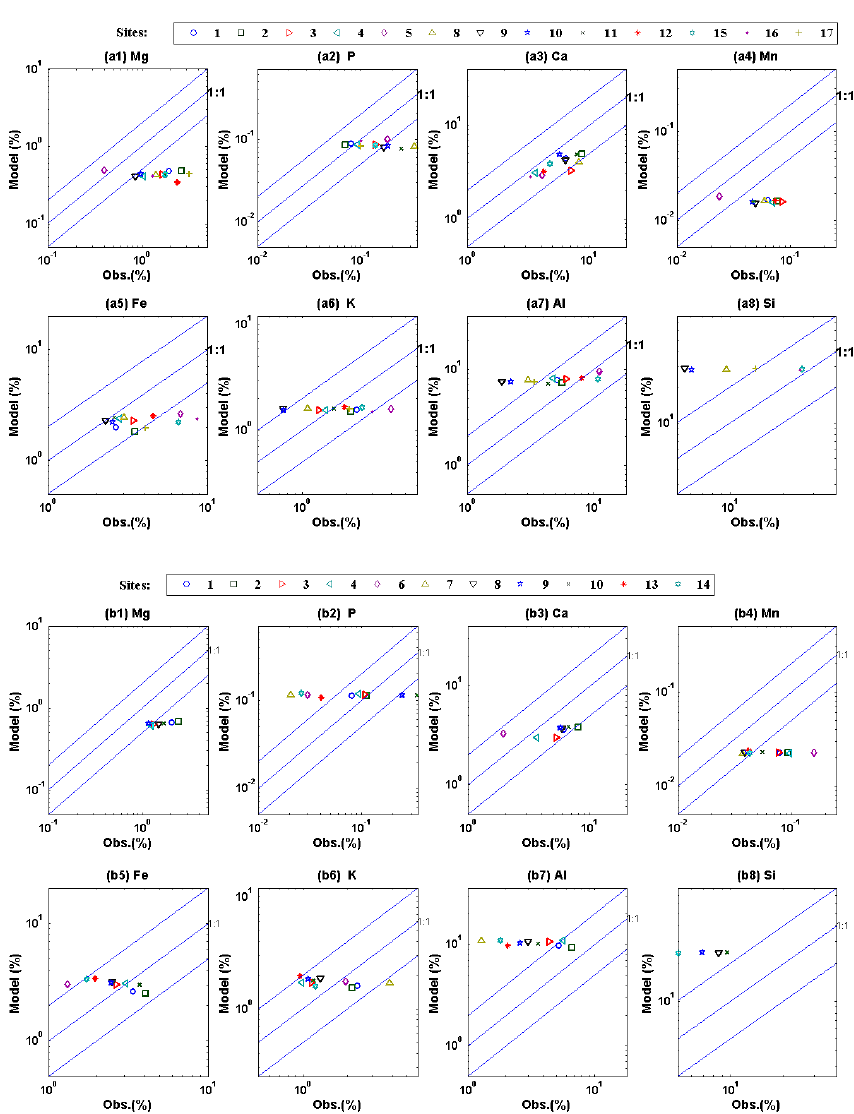
Figure 10. Comparison of observed and modeled mean fractions of elements at each site for (a) total suspended particulates (TSP) and (b) PM 2 . 5 . (1-Hetian, China; 2-Tazhong, China; 3-Yulin, China; 4-Duolun, China; 5-Shengsi, China; 6-Hanoi, Vietnam; 7-Manila, Philip- pines; 8-Balad, Iraq; 9-Baghdad, Iraq; 10-Taji, Iraq; 11-Eilat; 12-Cape Verde Atmospheric Observatory (CVAO); 13-Muswellbrook, Aus- tralia; 14-Richmond, Australia, 15-Tamanrasset, Algeria; 16-Banizoumbou, Niger; 17-Douz, Tunisia). Here we calculate the elemental frac- tions and average the fractions temporally for each site and compare to